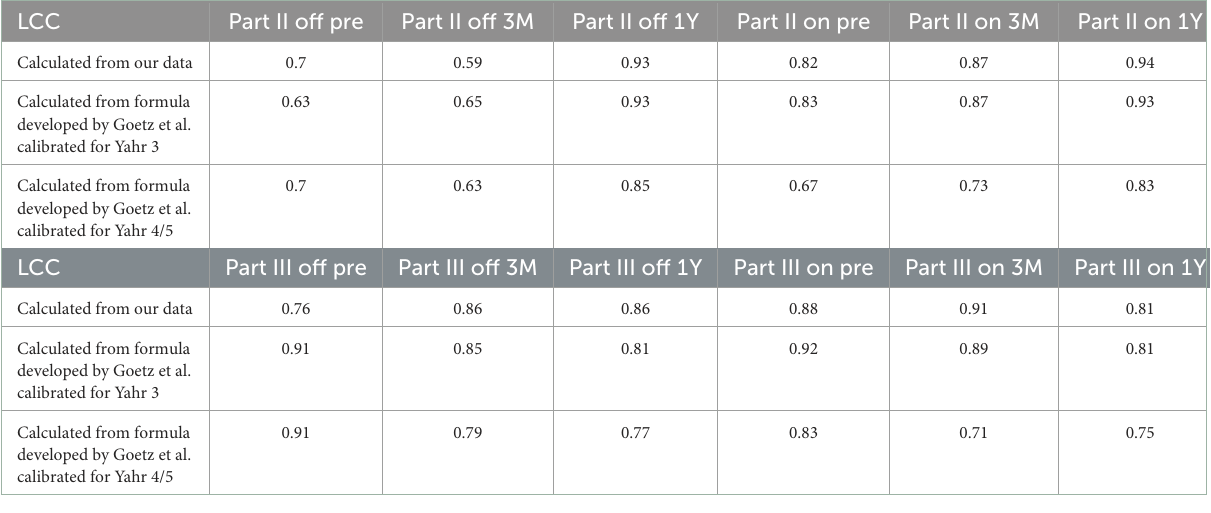
TABLE 3 Lin’s concordance coefficients (LCC) between MDS-UPDRS and estimated MDS-UPDRS calculated from our data and formula developed by Goetz et al. calibrated for Hoehn and Yahr 3 and Hoehn and Yahr 4/5.